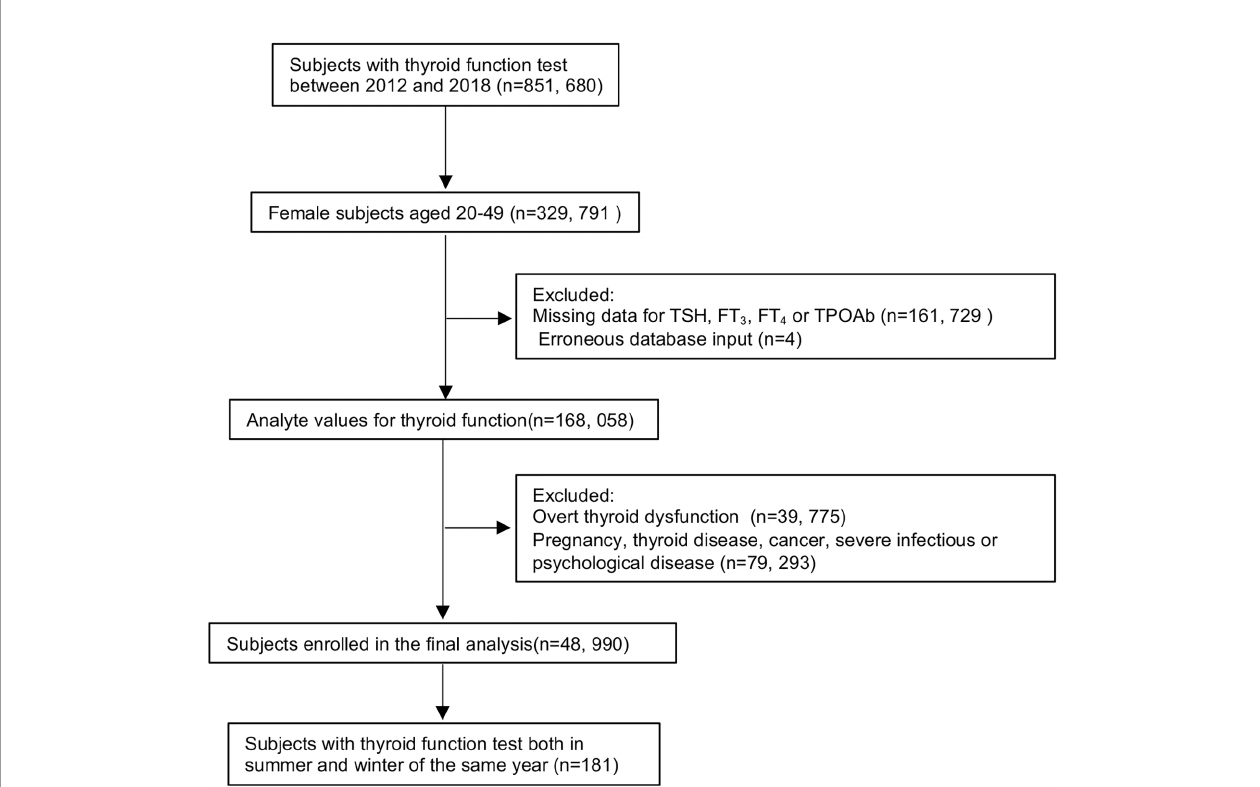
FIGURE 1 | Flowchart of study participant inclusion and exclusion. Abbreviations: TSH, thyrotropin; FT 3 , free triiodothyronine; FT 4 , free thyroxine; TPOAb, thyroid peroxidase